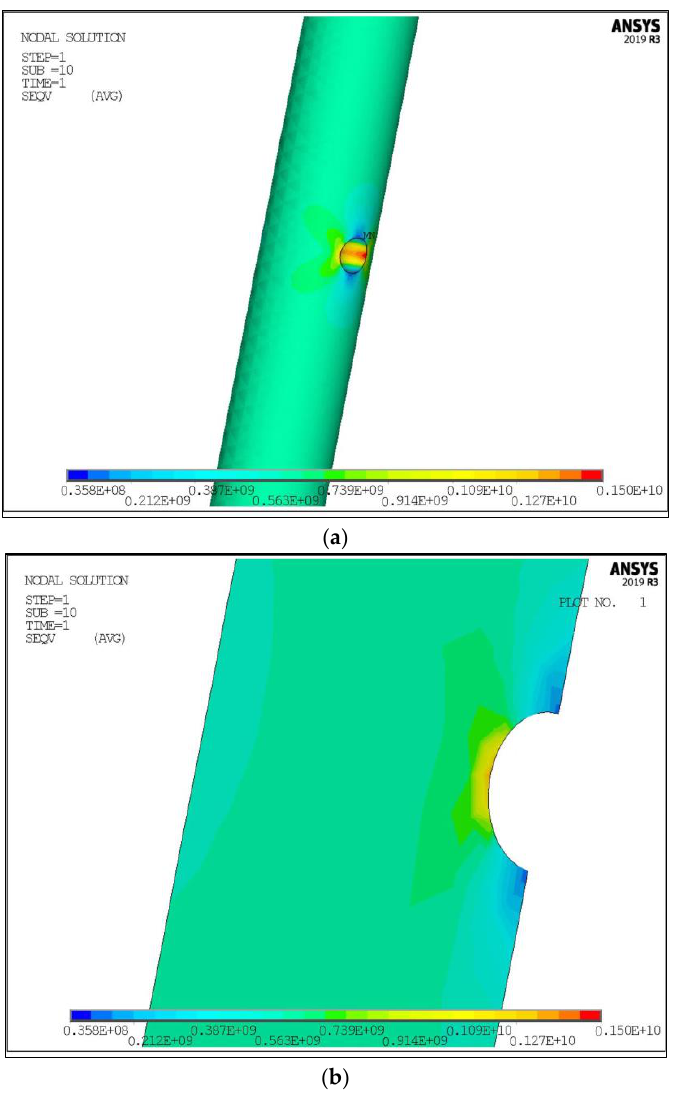
Figure 11. Von-Mises equivalent stresses for a wire with a semi-spherical corrosion pit with a radius of 0.8 mm: ( a ) Contour plot; ( b ) Cross-section plot.